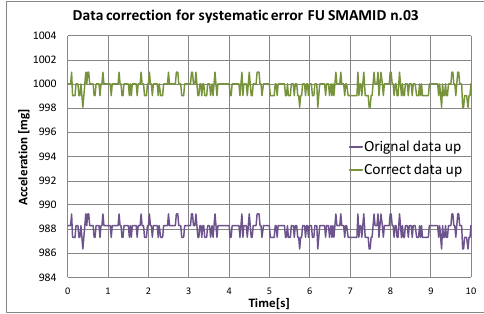
Figure 4. Laboratory static test - Observations adjusted from systematic errors – session acquisition of 10 seconds